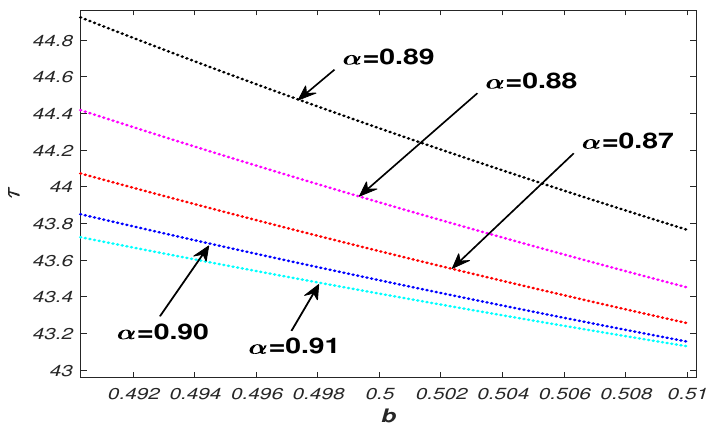
Figure 10. Influence of fixed vaccination rate b (continuous case) and secondary vaccination rate α (discrete case) on the critical time τ